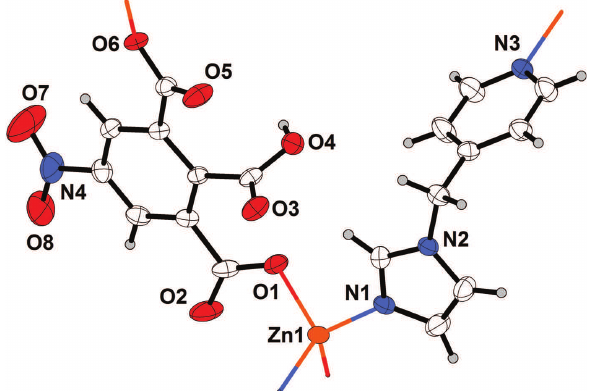
Table 1: Data collection and